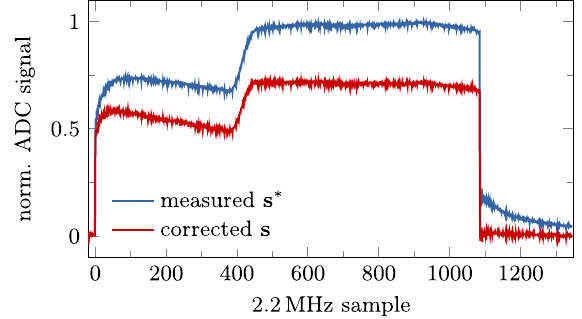
15. Example of the ADC signals samples with the bunch repetition rate before (blue) and after (red) pileup